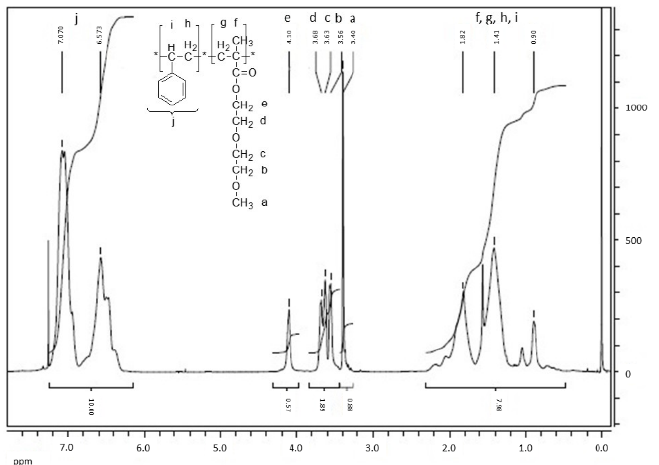
Figure 6. 1 H NMR spectrum of Sample A1 with the protons assigned to the appropriate chemical shifts.